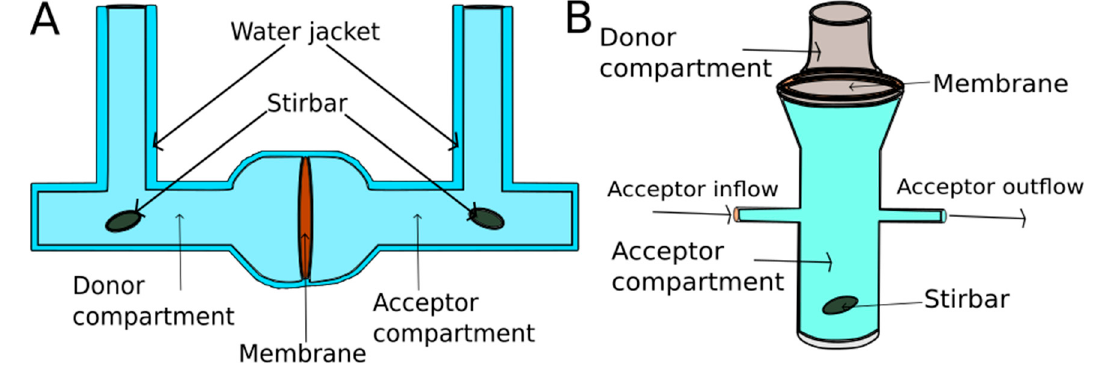
Figure 7. Side-by-side cell ( A ) and flow-through cell ( B ).